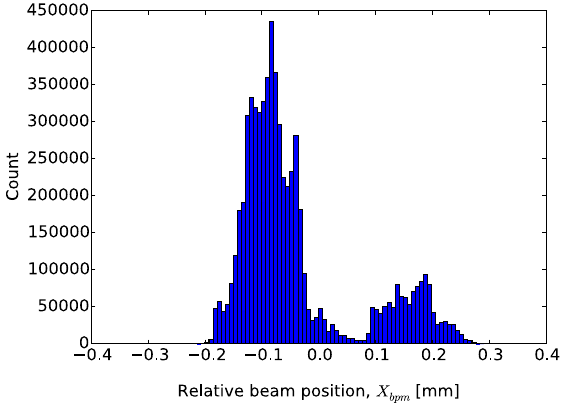
FIG. 17. The distribution of the measured orbit at the TCTPH.4L1.B1 during all proton-proton stable beams periods in 2016. 99% of the orbit drifts with respect to the collimator center are within 235 μ